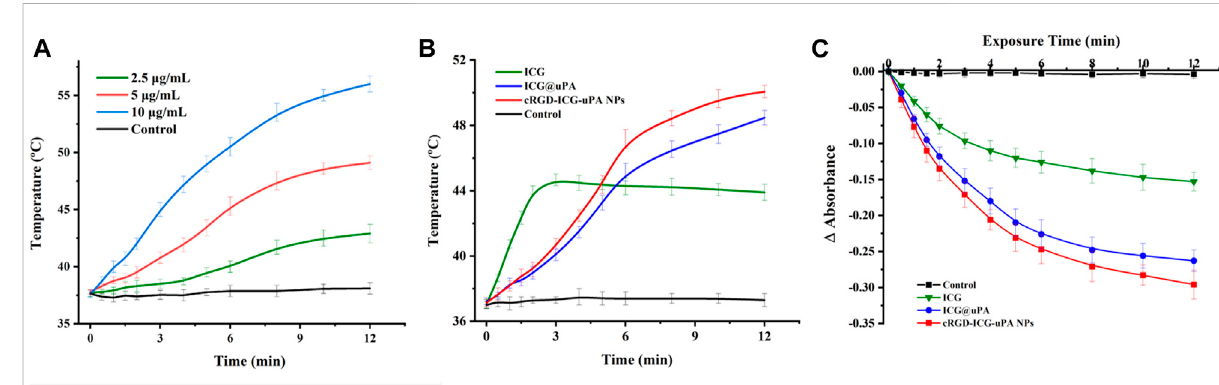
FIGURE 3 (A) Temperature elevation curves of cRGD-ICG-uPA NPs aqueous solutions of different ICG concentration (2.5, 5, and 10 μ g/ml) under NIR irradiation (1 W/cm 2 ) ( n = 3). (B) Temperature elevation curves of free ICG, ICG@uPA, and cRGD-ICG-uPA NPs in aqueous solutions under